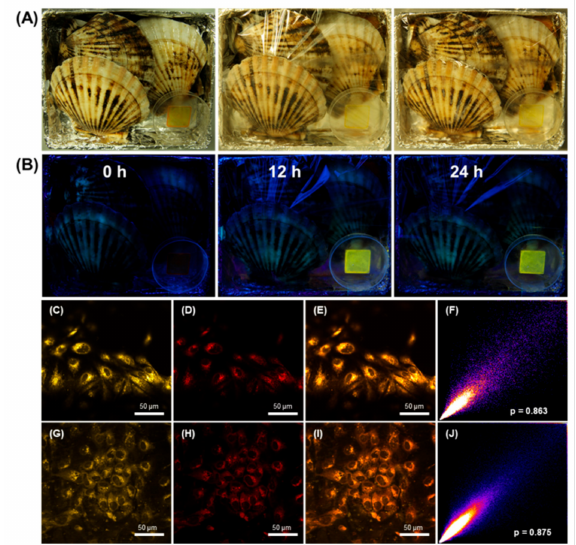
Figure 2. ( A , B ) Spoilage detection of scallops in sealed packages for 24 h at room temperature using H2P15a/16a/17a2+ thin film. Photographs taken under ( A ) normal room light. ( B ) 365 nm UV irradiation. ( C – J ) Confocal images of ZF4 cells co-stained by ( C – F ) P 18-1 (10 × 10 − 6 m, 2 h) or ( G – J ) P 18-6 (10 × 10 − 6 m, 2 h) with LysoTracker Red (LTR, 10 × 10 − 6 m, 0.5 h). ( C , G ) Yellow channel: excitation wavelength at 405 nm and emission range at 500–600 nm for P 18-1 and P 18-6 . ( D , H ) Red channel: excitation at 561 nm and emission range in 580–680 nm for LTR. ( E , I ) Merged image of yellow and red channel. ( F , J ) Scatter plot indicated the overlap coefficient between the imaging result of P 18-1 or P 18-6 with LTR (inset: Pearson ’ s correlation coefficient). (Copyright 2019, Wiley).